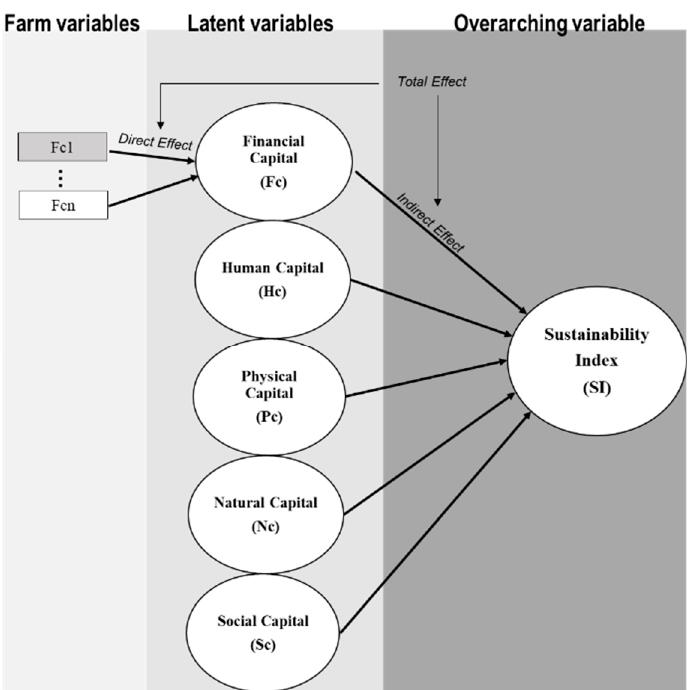
Figure 2. Path diagram of the confirmatory factor analysis model for the livelihood sustainability index (SI). The diagram is a graphic representation of the relationships among all the variables in our model. The observed farm variables are represented in a rectangular form, the capitals and the sustainability, represented in an elliptical form, are conceived as latent variables that cannot be measured directly, but can be inferred through a composed index of a set of observed farm variables. The relationships between variables are represented with straight arrows. SI: sustainability index, Fc: financial capital, Hc: human capital, Pc: physical capital, Nc: natural capital, Sc: social capital. Fc1.n are farm variables for financial capital.